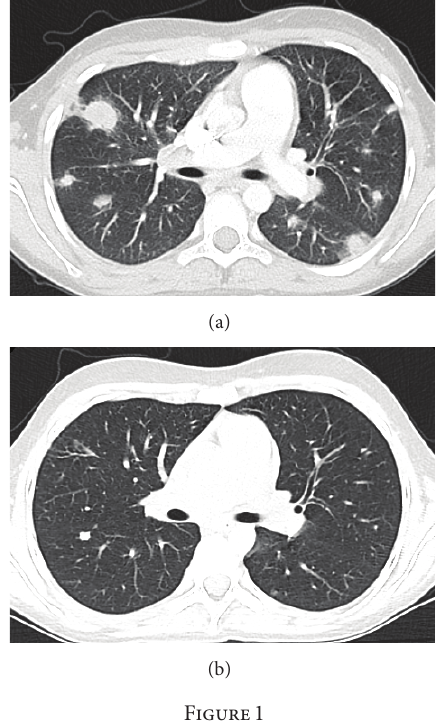
in the gp47 phox gene (c.75 76delGT), which is known to be causative for autosomal recessive CGD. His parents and an older sister were all found to be heterozygous for the same